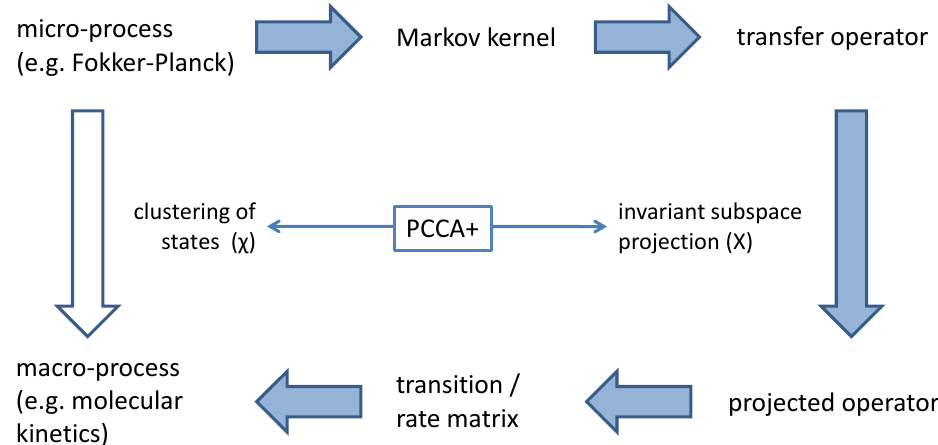
Figure 2. A clustering of micro-states based on membership functions χ leads to a definition of a macro-system. In order to derive a physical law for the time-dependent propagation of macro-states from the propagation of the micro-system a projected transfer operator is constructed. For this projection an invariant subspace X of the transfer operator is used. PCCA+ defines the relation between X and χ